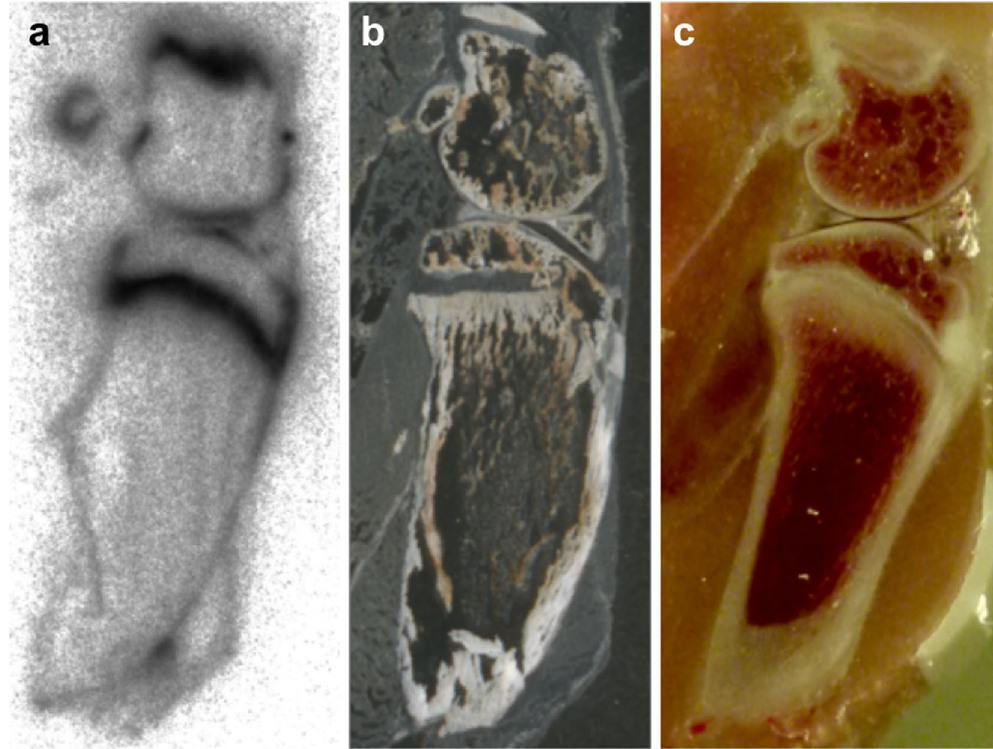
Figure 6. Distribution in the bone. Representative ( a ) radioluminogram, ( b ) histological frozen section (20 µ m), and ( c ) photography from 4 independent studies of rat femur surface 4 h after single intravenous injection of [ 64